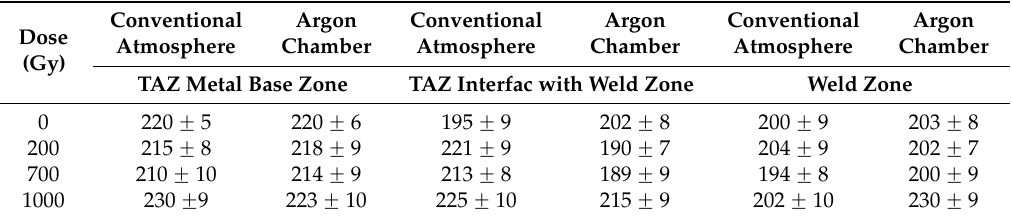
Table 3. Hardness test results for different radiation doses and types of